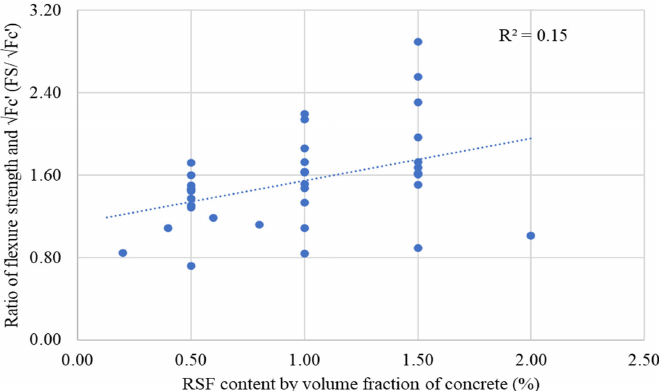
Figure 21. Effect of RSF on the ratio between compressive strength and flexure strength.